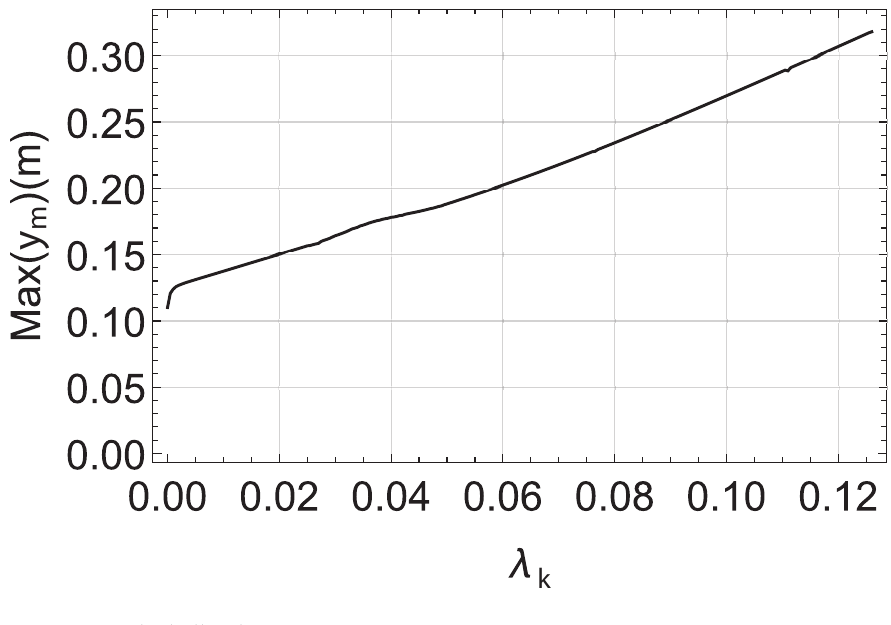
Figure 10. Basketball Robot Response Curve, ω d = 25.7.